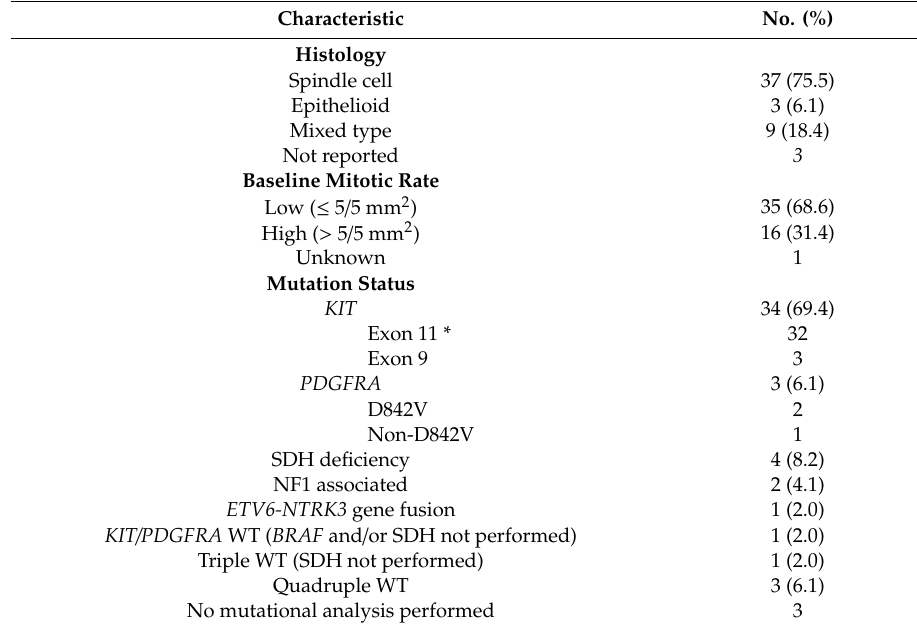
Table 2. Pathology and tumour genetic results of young-adult patients.